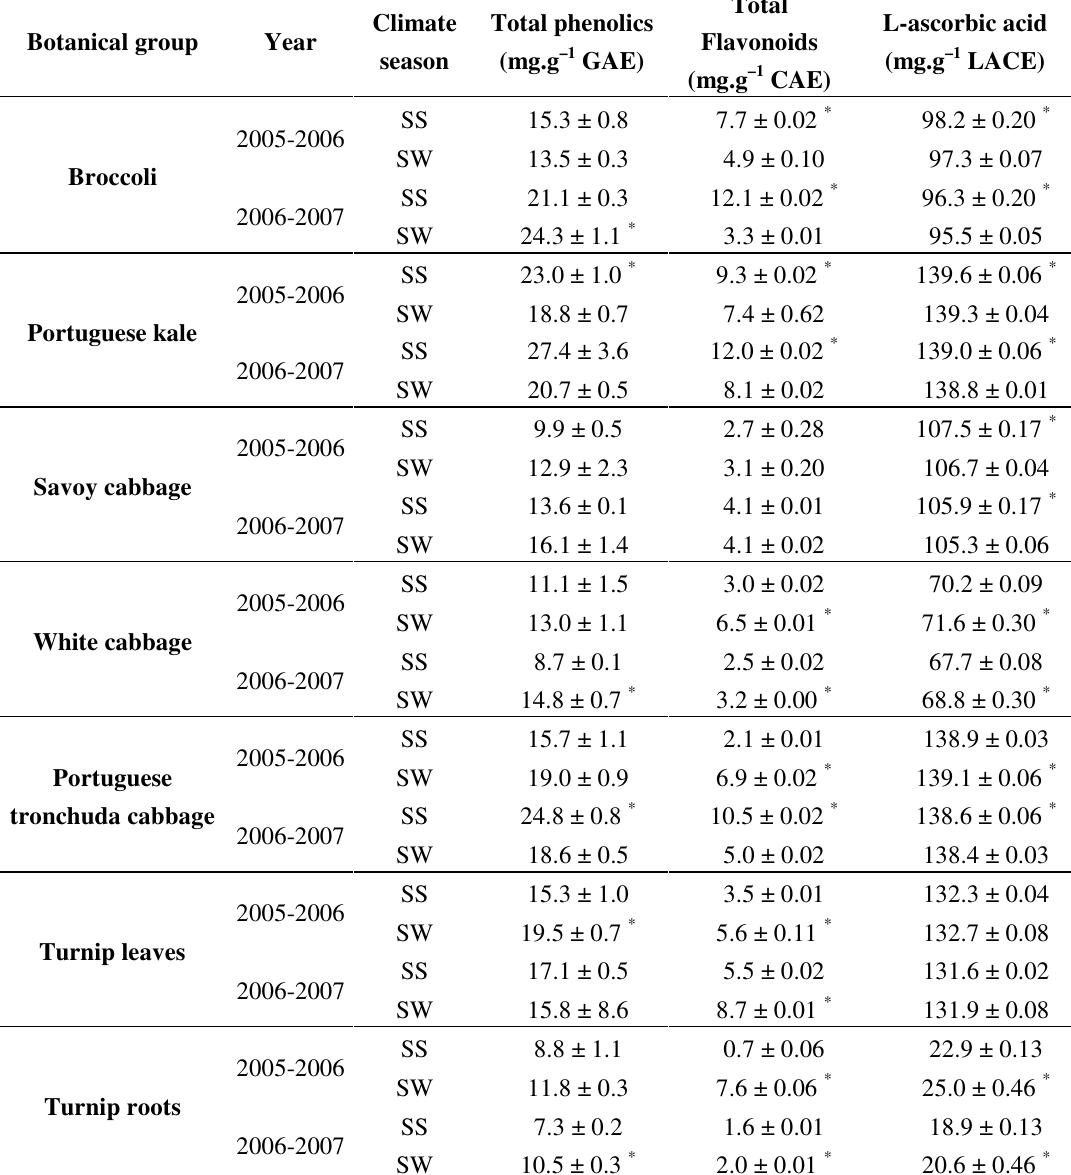
Table 2. Mean content of total phenolics, total flavonoids and L -ascorbic acid in different Brassica samples produced in two consecutive years and two different climate